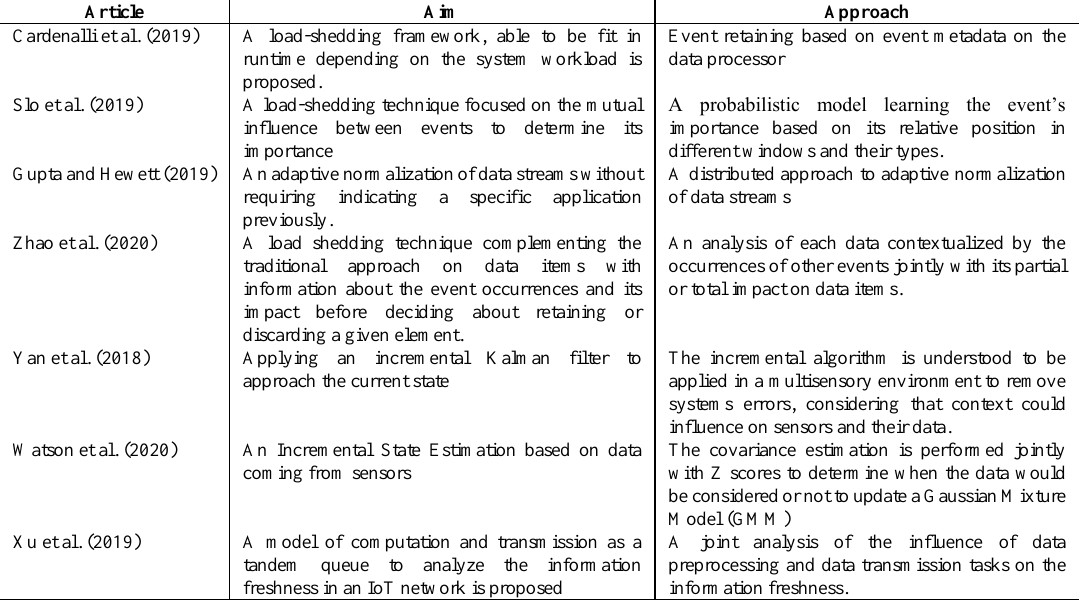
Table 1. A comparative perspective of the aim and approach of each related